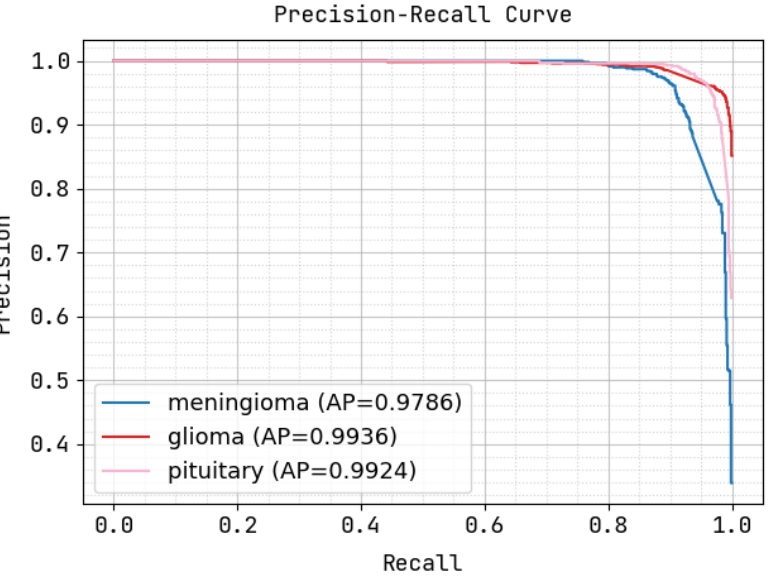
Figure 6. Precision–recall curve correlation.